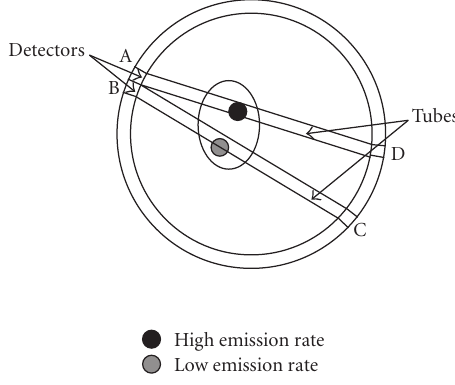
Figure 1: Gamma rays escape the body and are observed by the